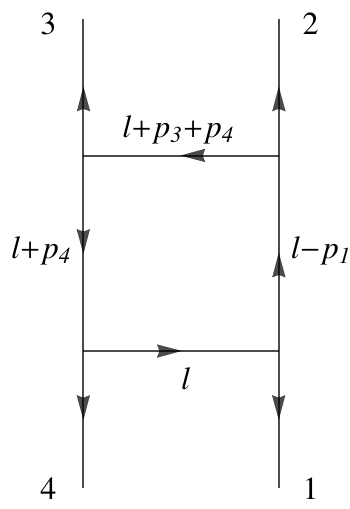
Figure 28 . One-loop scalar box